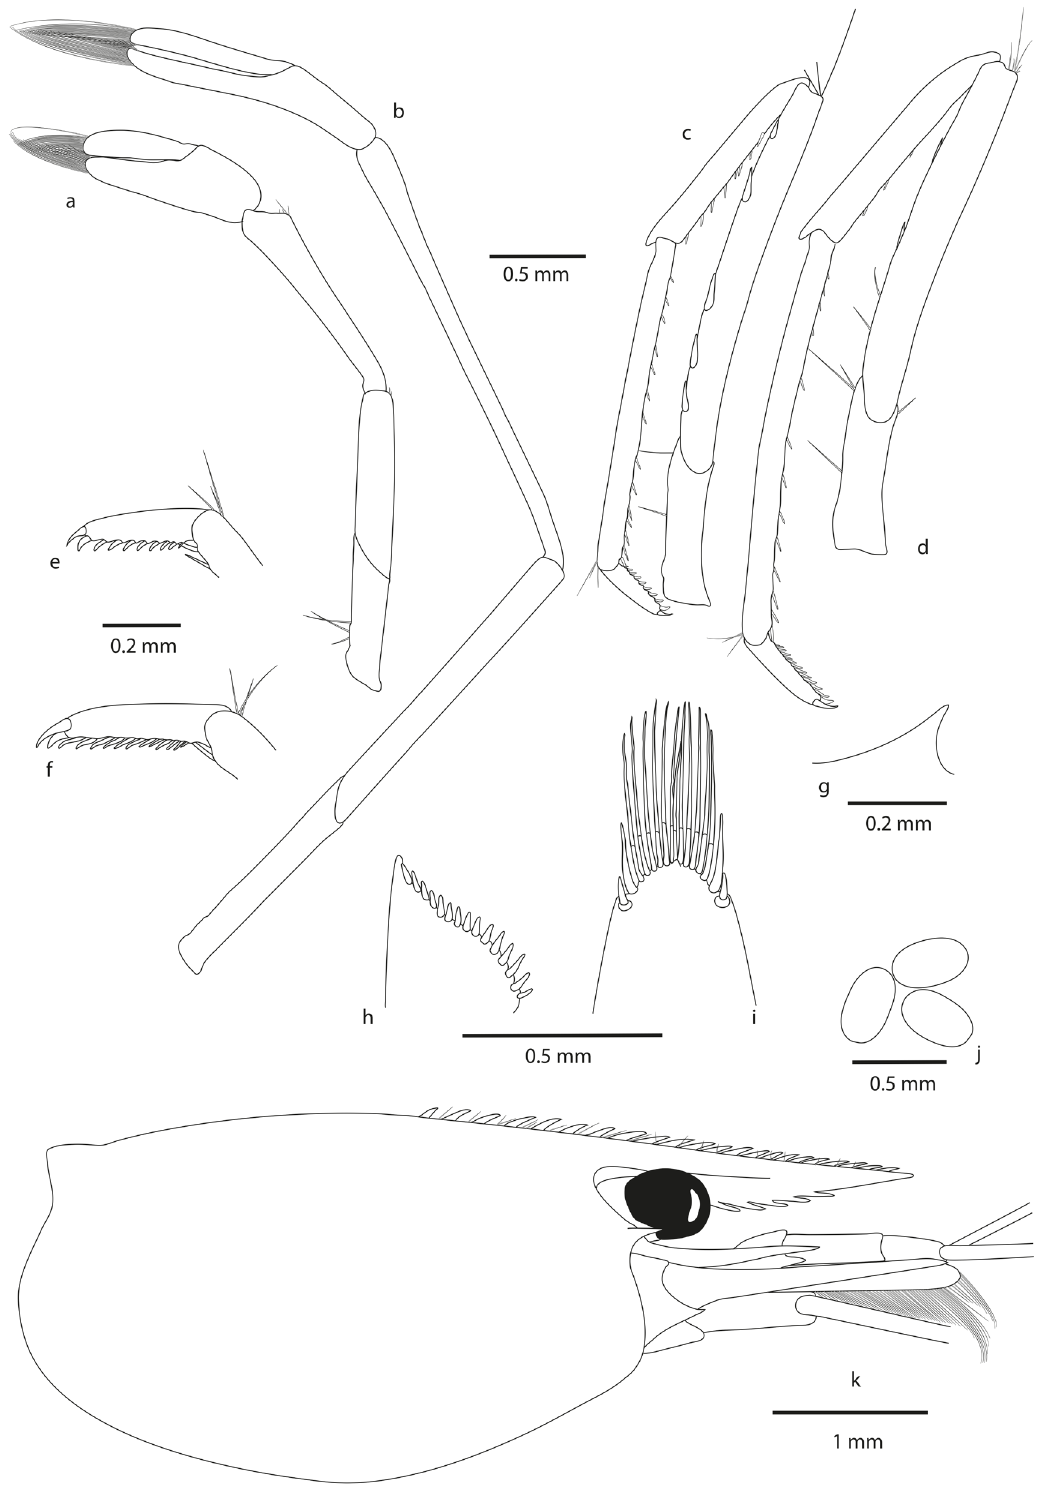
Fig. 24. Caridina celebensis De Man, 1892. a . First pereiopod. b . Second pereiopod. c . Third pereiopod. d . Fifth pereiopod. e . Dactylus of third pereiopod. f . Dactylus of fifth pereiopod. g . Pre-anal carina. h . Uropodal diaeresis. i . Telson. j . Eggs. k . Cephalothorax. MNHN-IU-2018-2944 (a–f, j), MNHN- IU-2018-2946 (g) and MNHN-IU-2018-2943 (h–i,